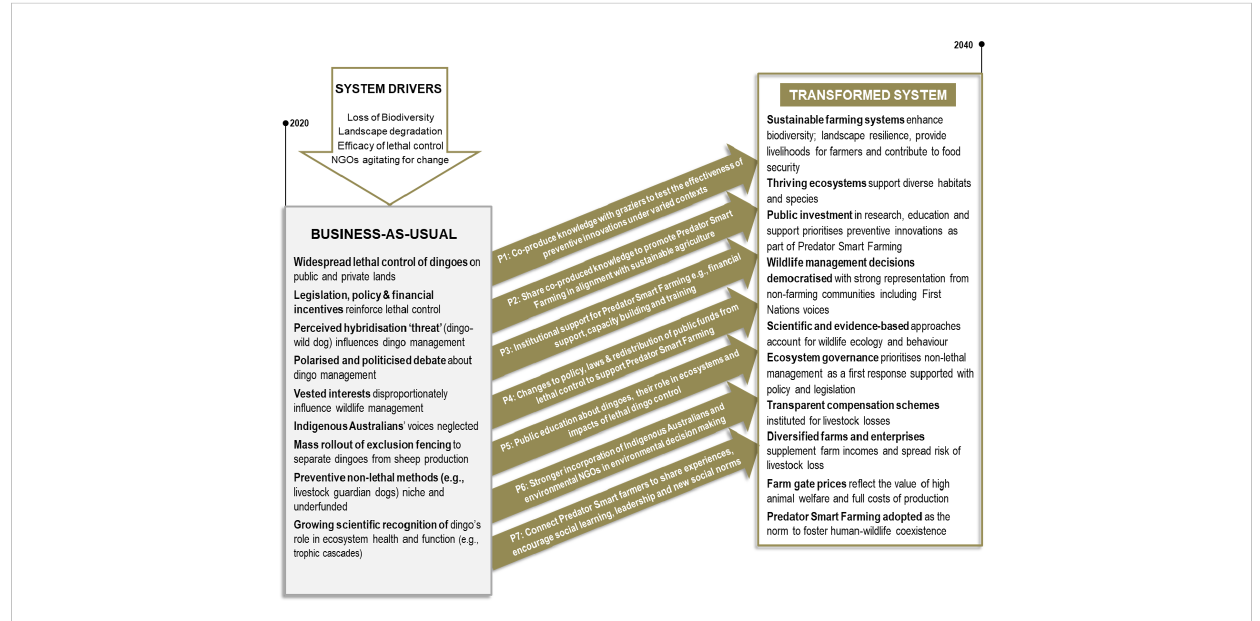
FIGURE 2 A qualitative model of transformative change in extensive grazing systems in